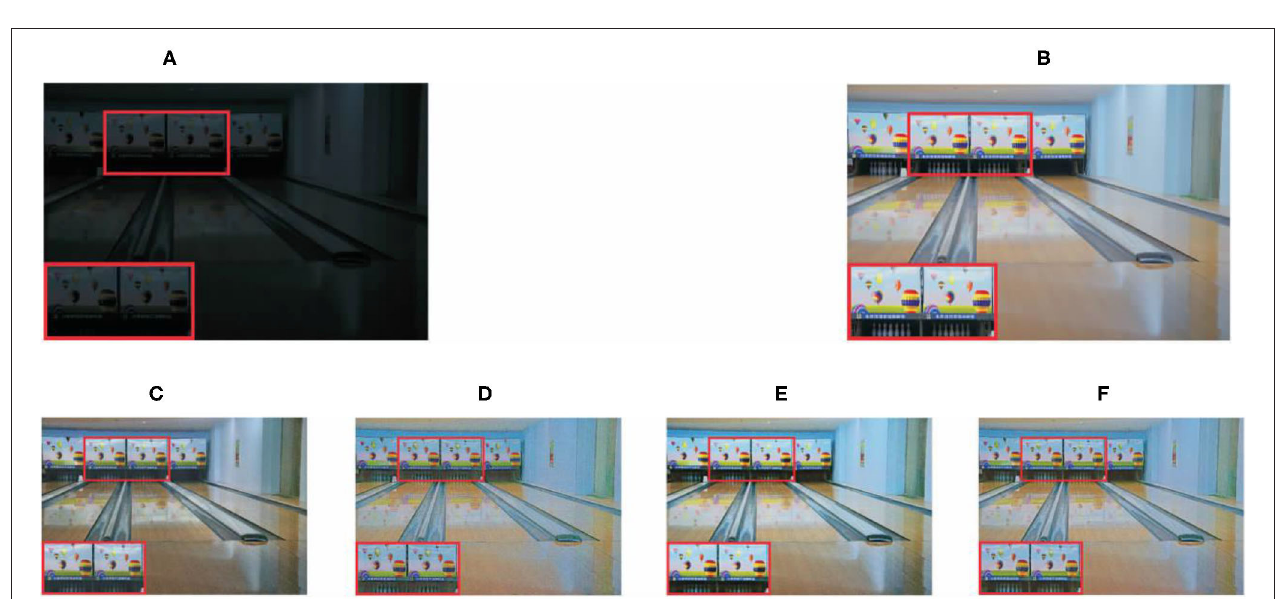
FIGURE 5 | Comparison results with different algorithms on LOL dataset. (A) Original image, (B) ground truth, (C) SEM method, (D) VBSA method, (E) APM method, and (F) proposed method.